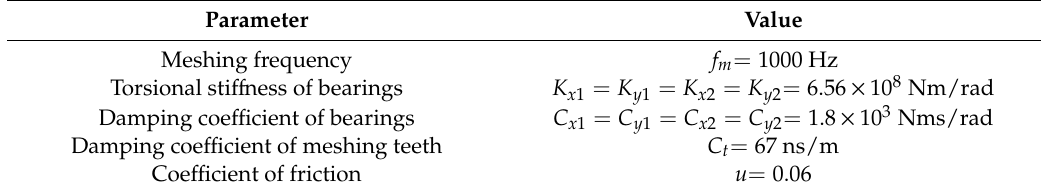
Table 4. Main parameters of the transmission